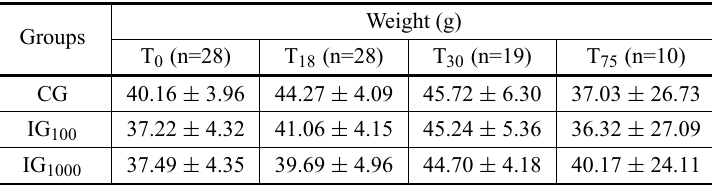
Average body weight of Swiss male mice infected with 100 (IG 100 ) and 1000 (IG 1000 ) forms of blood trypomastigotes from T. cruzi Y strain and the non-infected controls (Control Group –